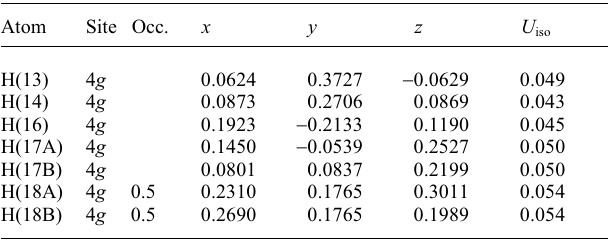
Table 2. Atomic coordinates and displacement parameters (in Å 2 )